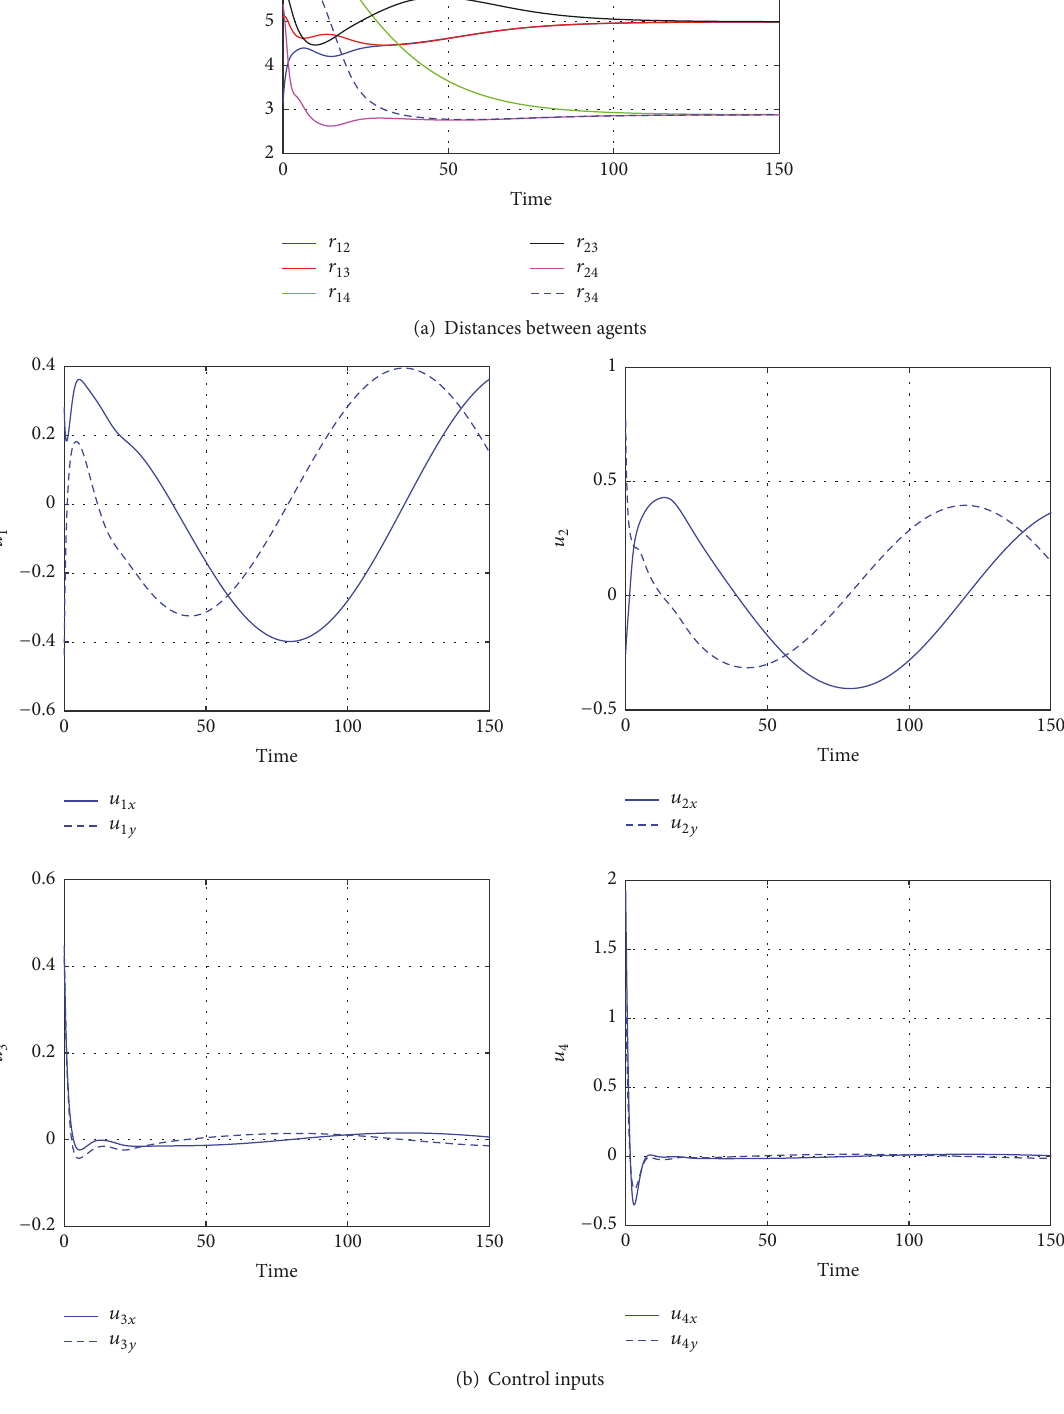
Figure 5: Simulation 1 results of distance-based formation with 𝑛 = 4 , 𝑛 1 = 2